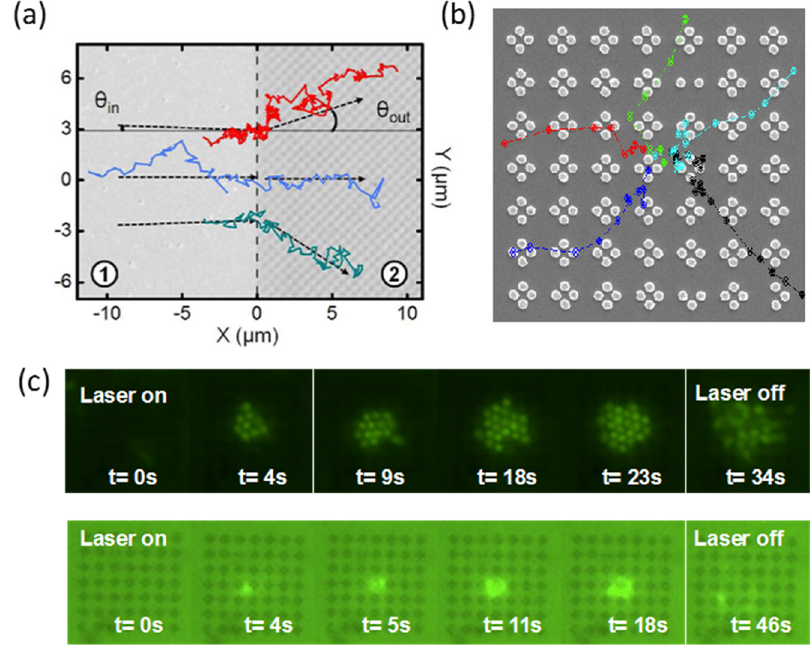
Figure 4. Trapping and transport in plasmonic optical lattices. ( a ) Real space trajectory showing the negative refraction of a nanoparticle crossing the interface between Region 1 (a flat gold thin film) and Region 2 (an undulating gold thin film). Reproduced with permission from [57]. Copyright 2012, American Chemistry Society. ( b ) Single-particle trajectory over a nanoscale two-dimensional plasmonic optical lattice; ( c ) Multiple particle stacking over the same plasmonic optical lattice that is shown in (b). Reproduced with permission from [58]. Copyright 2013, American Chemistry